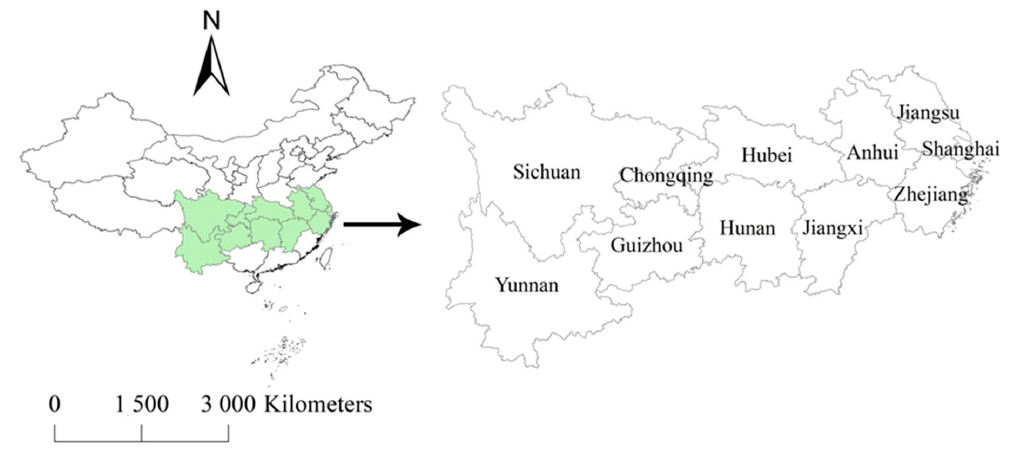
Figure 1. Location of the Yangtze River Economic Zone (YREZ) in China.